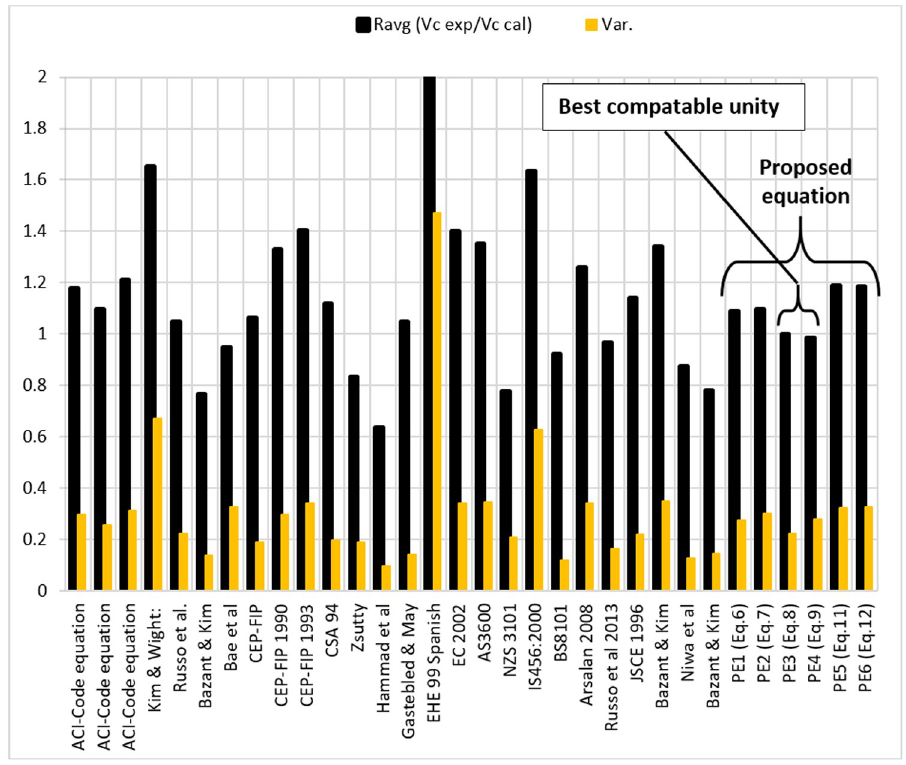
Fig 10. Statistical results of the available equations for predicting shear strength of HSC